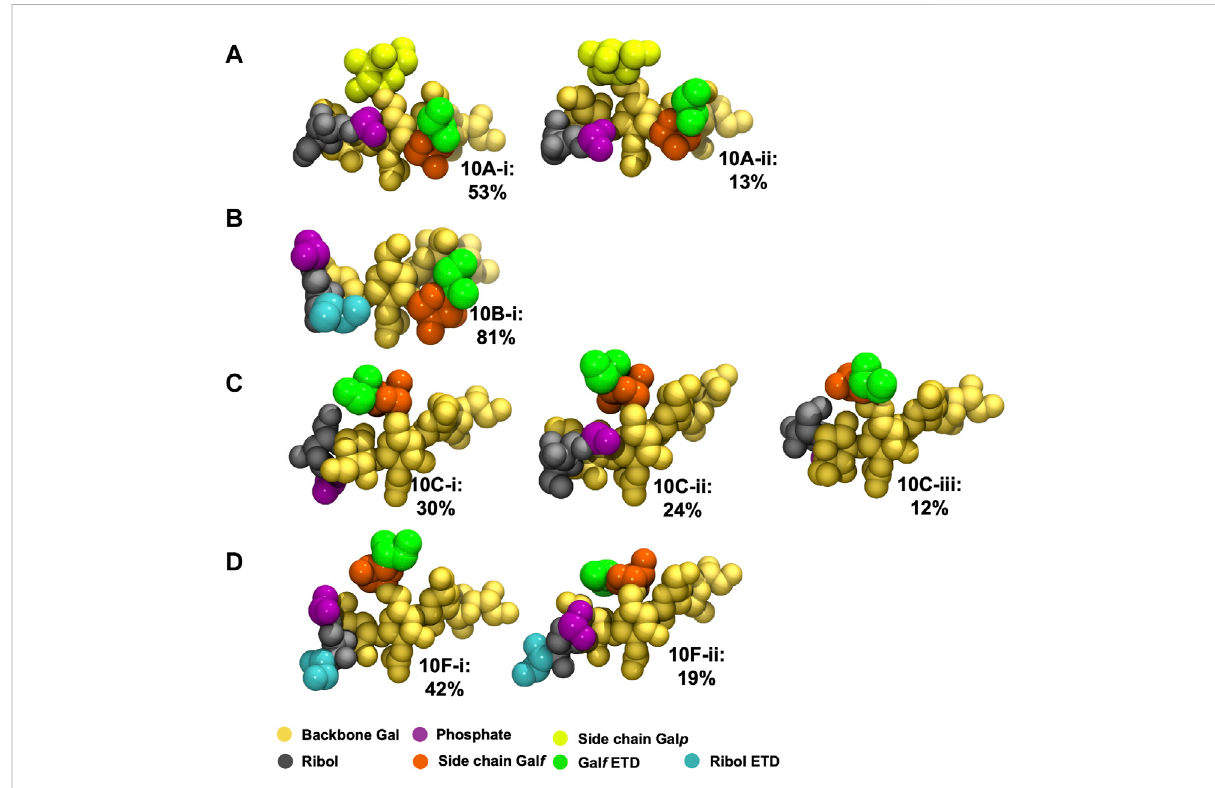
FIGURE 5 Mainconformationalfamiliesidenti fi edforRU4inthebackbone of6RU S.pneumoniae serotypeCPS: (A) Pn10A, (B) Pn10B, (C) Pn10C,and (D) Pn10F. Backbone galactose residues shown in yellow, Rib-ol-5P residues shown in grey, phosphate in purple, side group β Gal f residues in orange, side group β Gal residues in light green, ETD portion of β Gal f in green, and ETD portion of Rib-ol-5P residues in